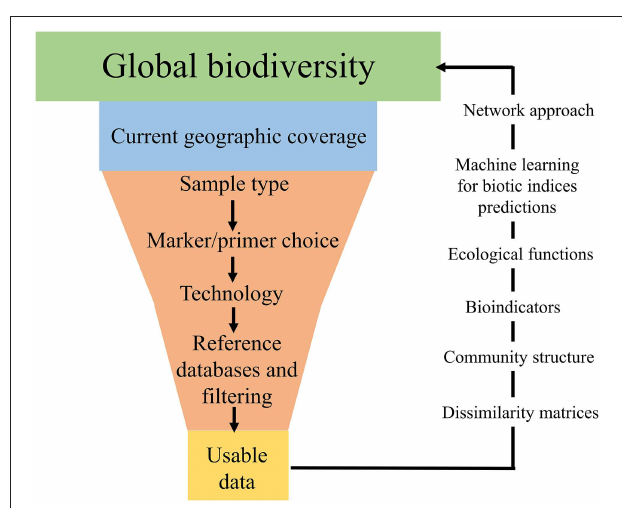
FIGURE 2 | Infographic displaying the “bottlenecks” associated with global DNA metabarcoding data